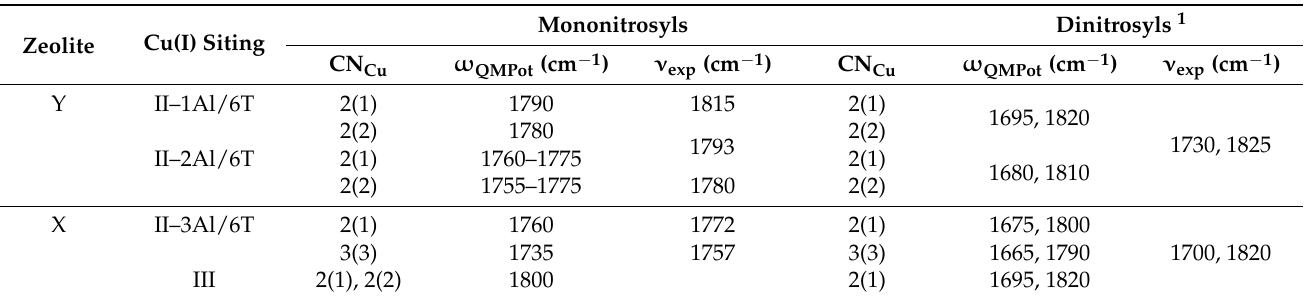
Table 1. The QMPot harmonic frequencies ( ω QMPot ) calculated for various models of Cu(I) nitrosyls in FAU zeolite (X and Y subtypes), and the proposed assignment of experimental frequencies ( ν exp )